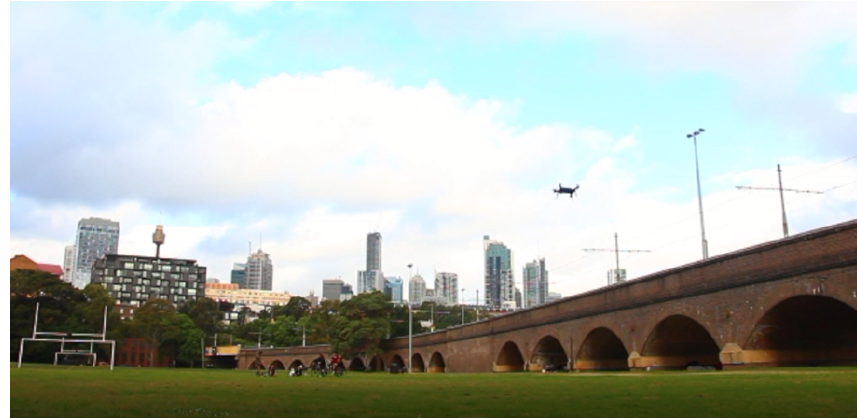
Figure 11. Flying 3DR Solo drone.